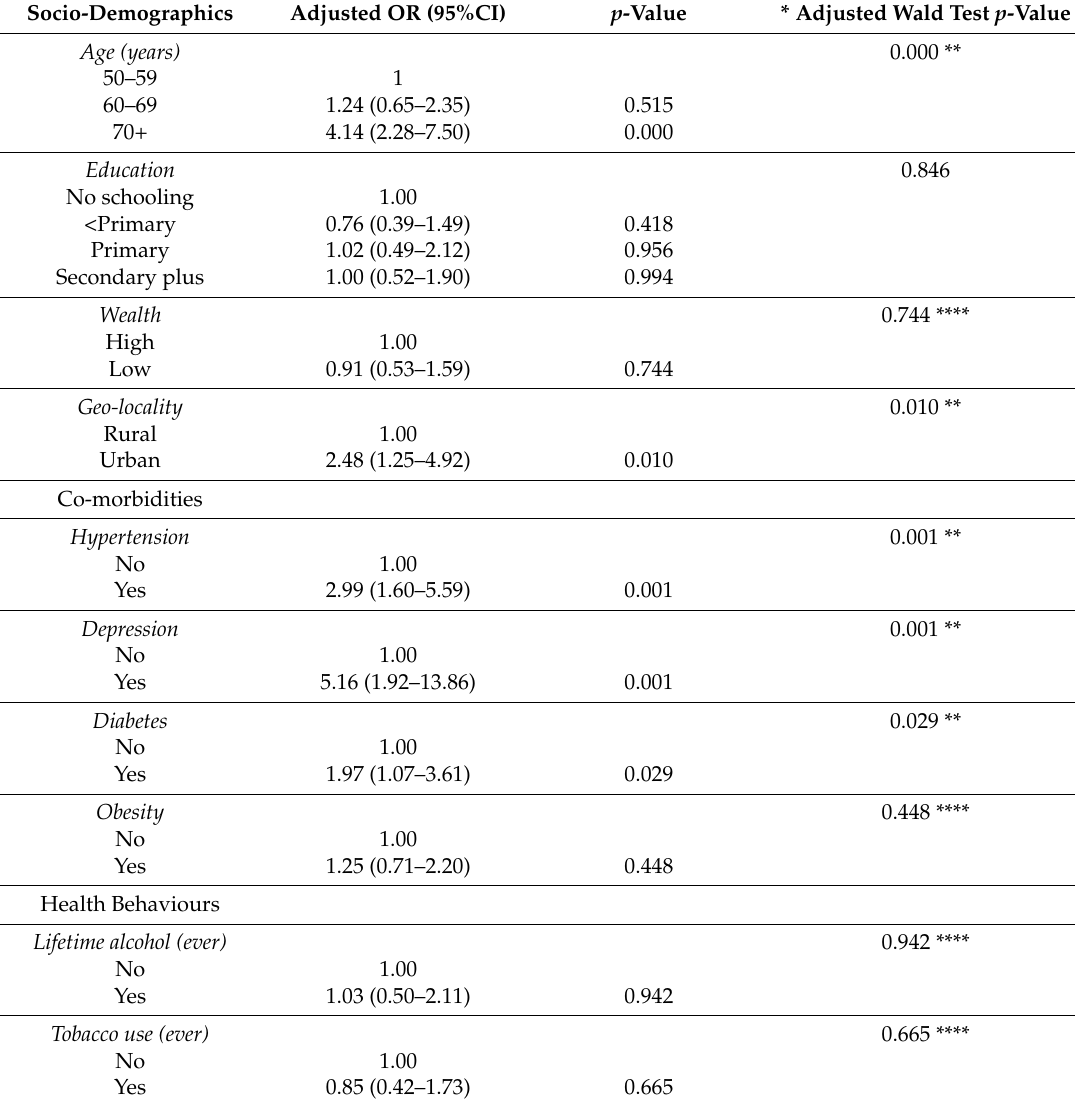
Table 3. Final multivariate model of risk factors for self-reported